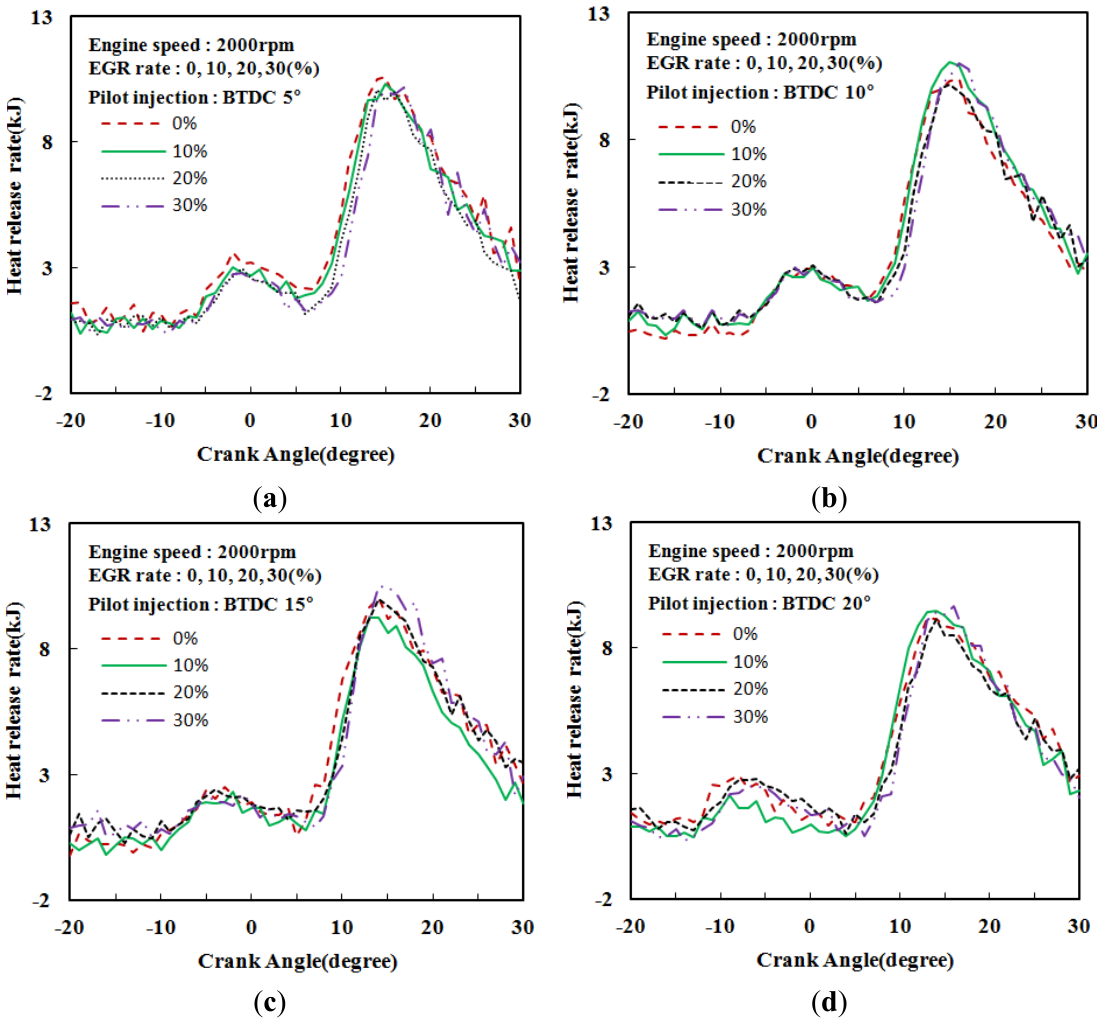
Figure 4. Comparison of HRR at various pilot injection timings and EGR rates. ( a ) BTDC 5; ( b ) BTDC 5; ( c ) BTDC 5; ( d ) BTDC